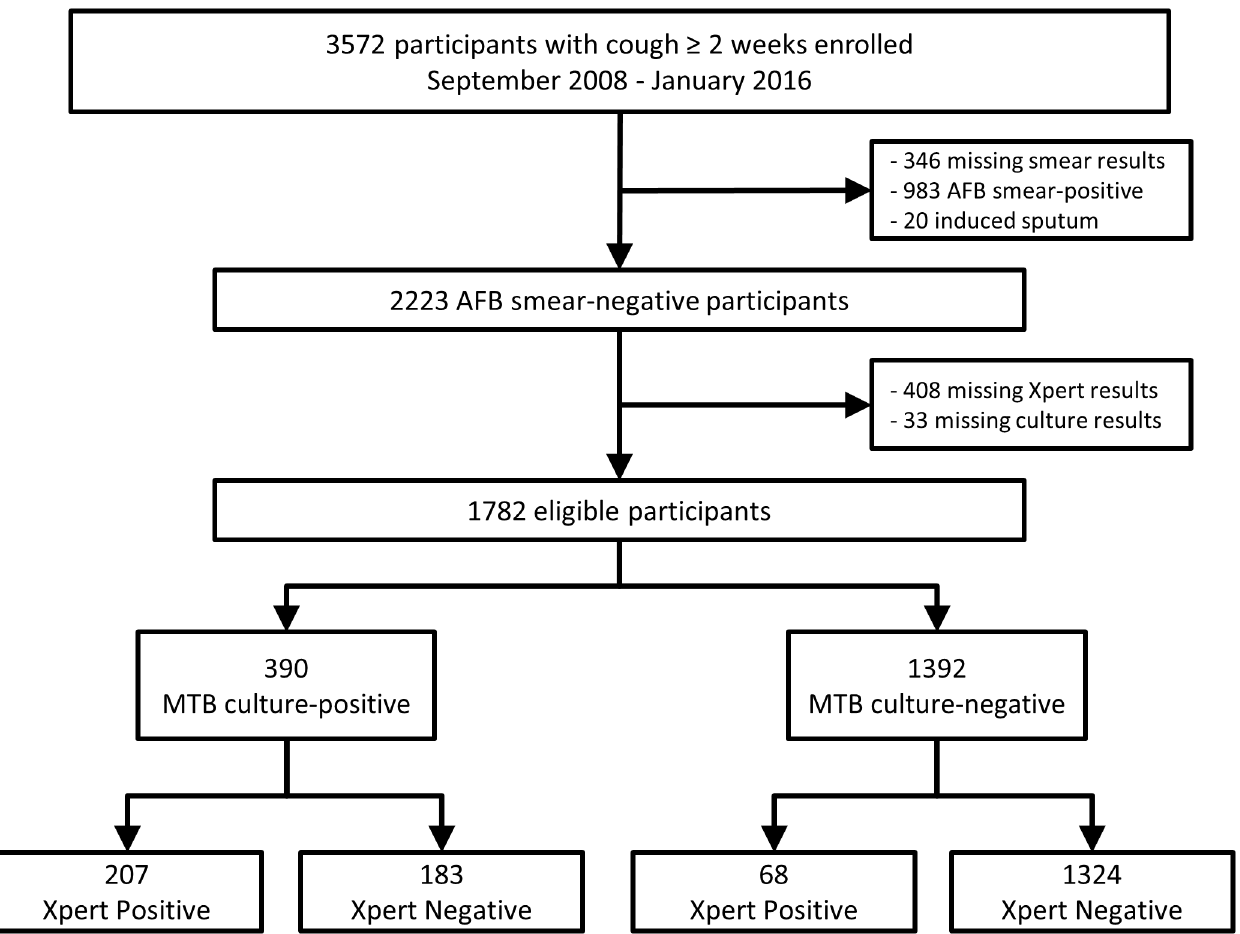
Fig 1. Study population. Abbreviations: AFB, acid-fast bacilli;MTB, Mycobacterium tuberculosis; Xpert, Xpert MTB/RIF assay.